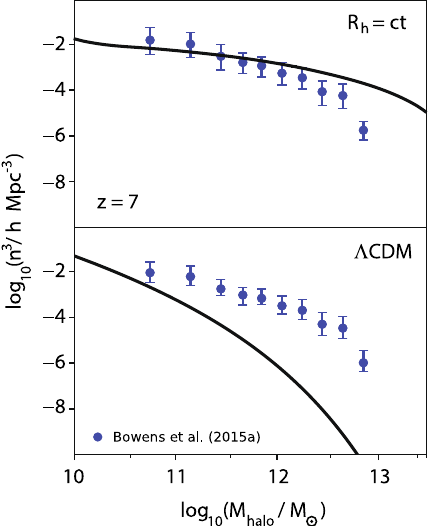
Fig. 6 Top: halo mass function inferred from galaxy surveys at z = 9 compared with R h = ct . Bottom: same, except now for Λ